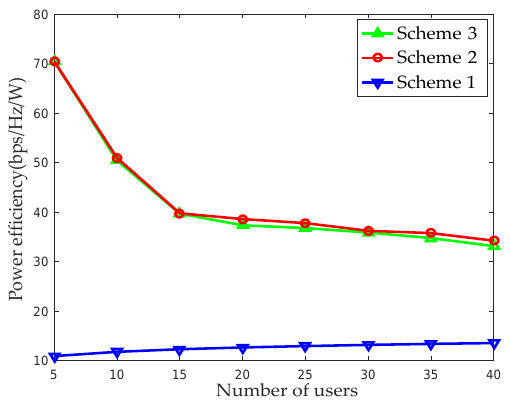
Figure 7. Power efficiency with respect to the number of UEs in